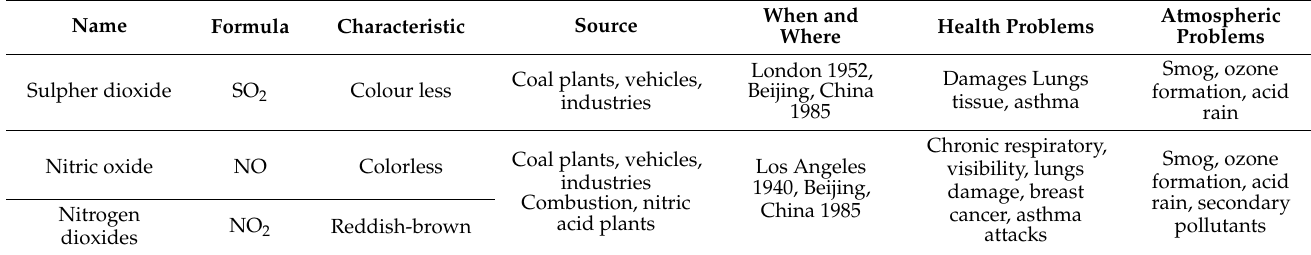
Table 1. Details of NO x and SO 2 combustion pollutants.